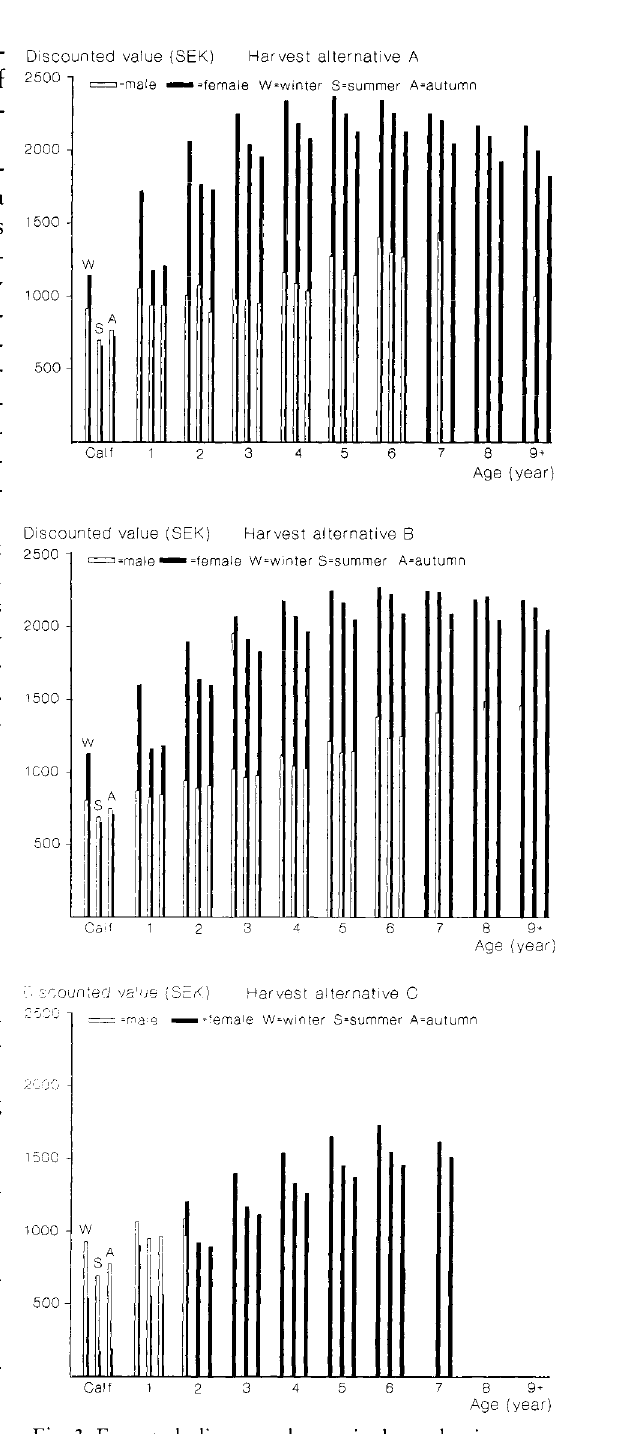
Fig. 3. Expected discounted marginal production va lues of animals lost at different ages and du ring different seasons in the three harvest al ternatives (A = combined calf and adult har vest, B = extreme calf harvest, C = extreme adult